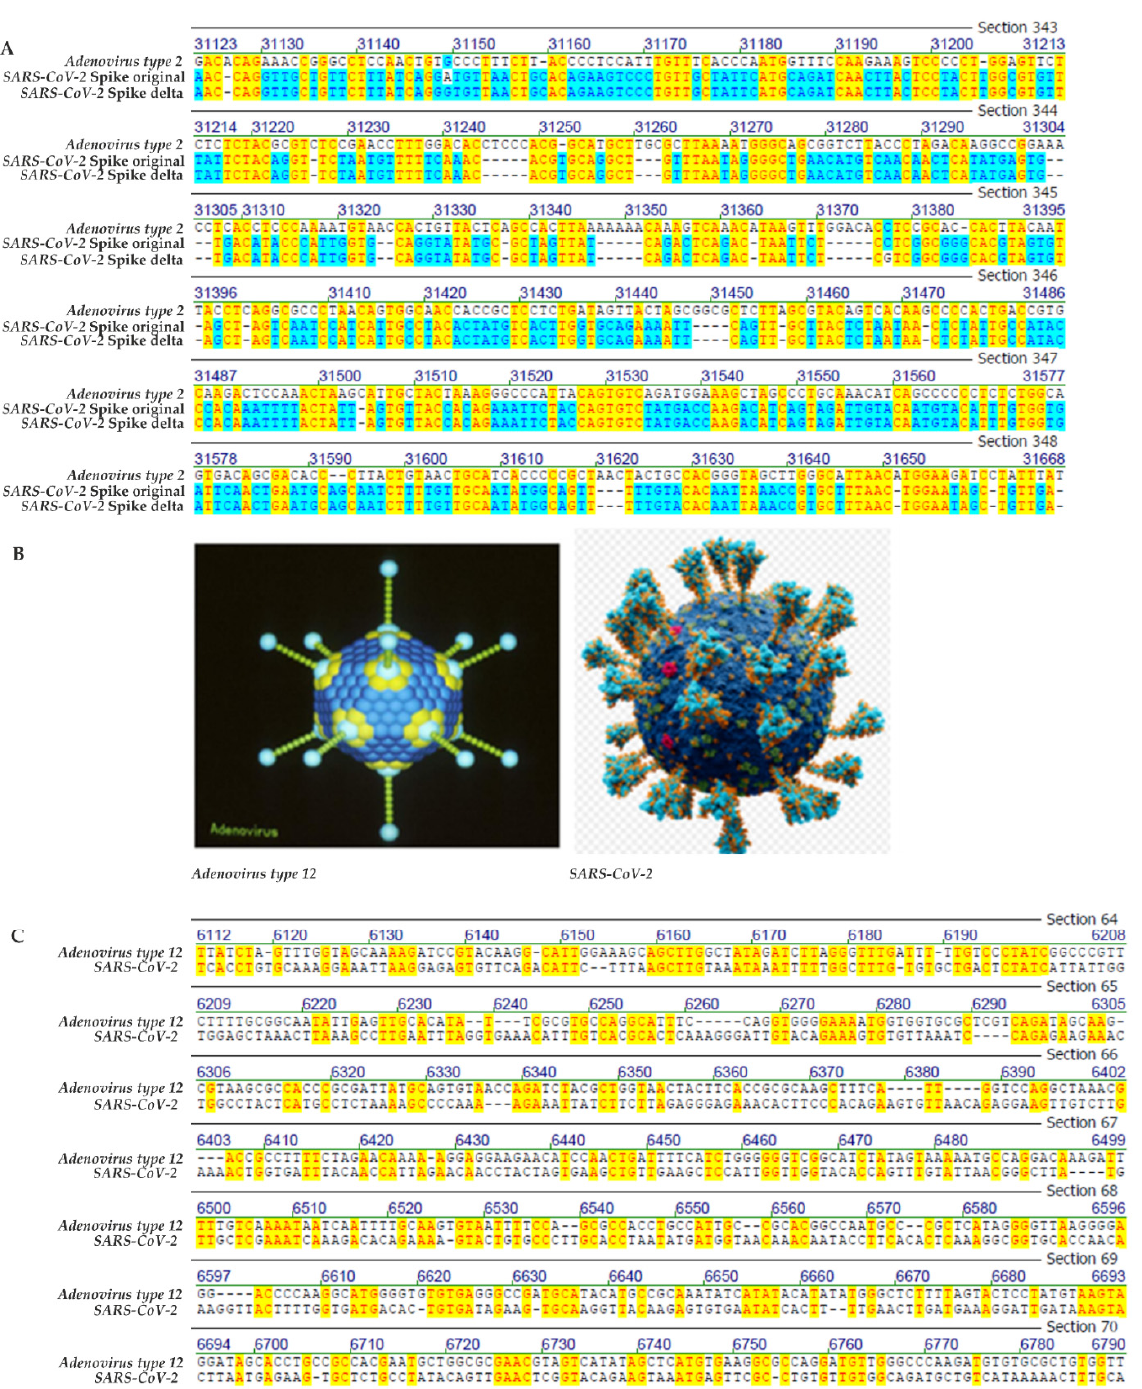
Figure 1. ( A ) SARS-CoV-2 original Wuhan and delta spike sequences versus fiber protein of human adenovirus type 2 (Ad2) . Segmental homology 45.1%. ( B ) Viral models of human adenovirus type 2 and SARS-CoV-2 . ( C ) Sequence alignment between Wuhan SARS-CoV-2 and adenovirus type 12 (Ad12) . The yellow highlight designates sequence identities between the genomes of SARS-CoV-2 and Ad2 ( A ) or Ad12 ( C ). The blue highlight stands for sequence identities between the nucleotide sequences of the SARS-CoV-2 spike in the WUHAN isolate and its delta variant.